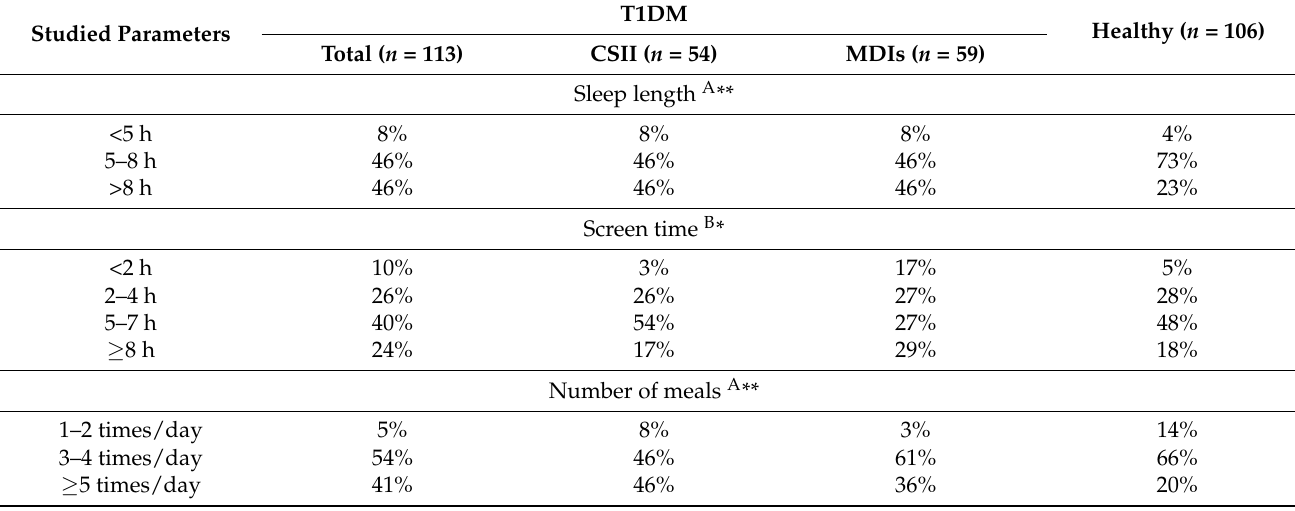
Table 3. Frequency of selected healthy behaviors.